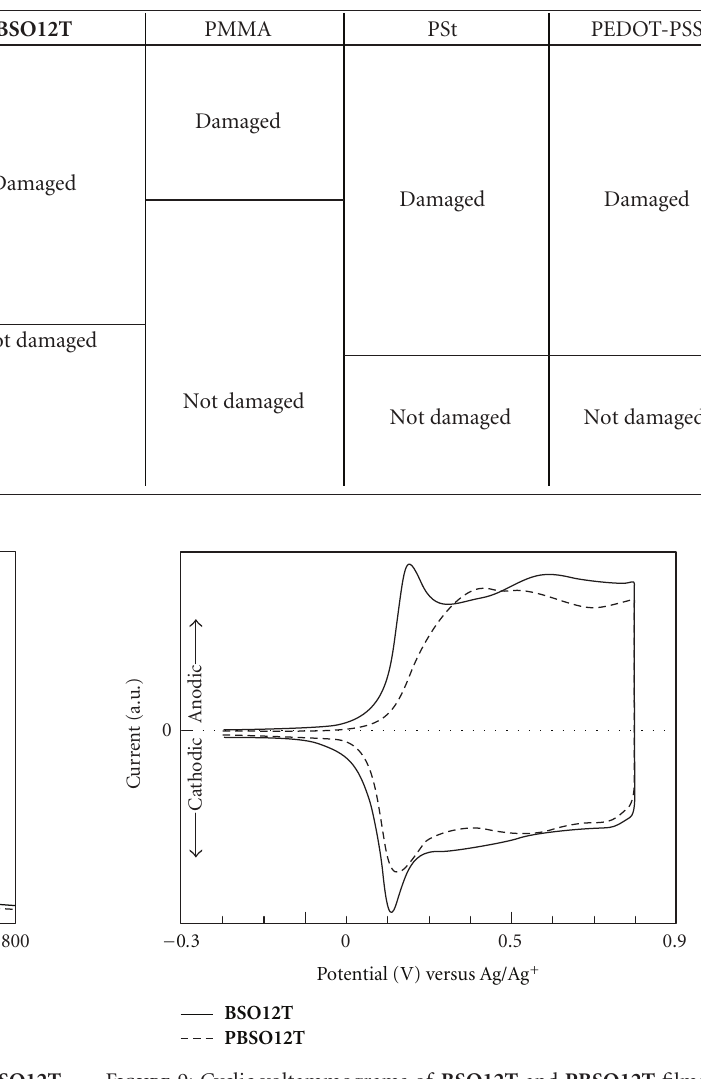
Figure 8: Absorption spectra of neutral BSO12T and PBSO12T films.